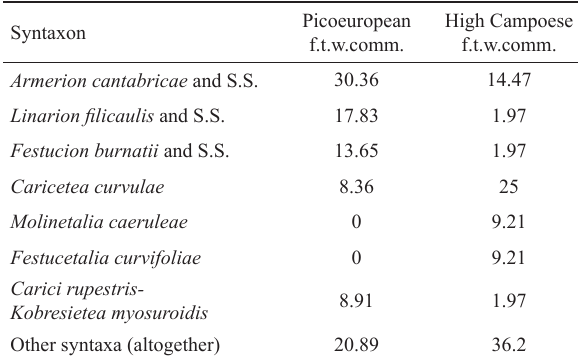
Table 1. Percentage participation in the main syntaxonomical groups obtained from Picoeuropean and High Campoese records of finely-toothed willow communities (f.t.w.comm.)relevés. The affinities of the records come from the bioindicator character - ization of each taxon (Rivas-Martínez et al ., 2011a). S.S. = superior syntaxa; f.t.w.comm. = finely-toothed willow com - munities. Picoeuropean High Campoese Syntaxon f.t.w.comm.